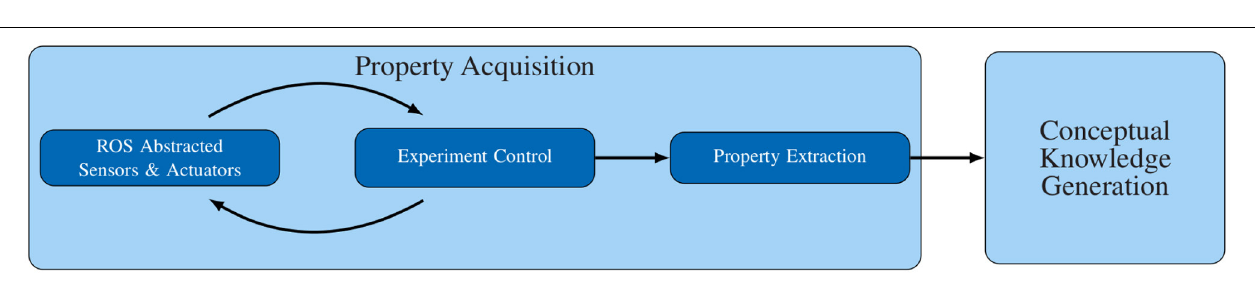
FIGURE 7 | Data flow within the dataset creation framework.